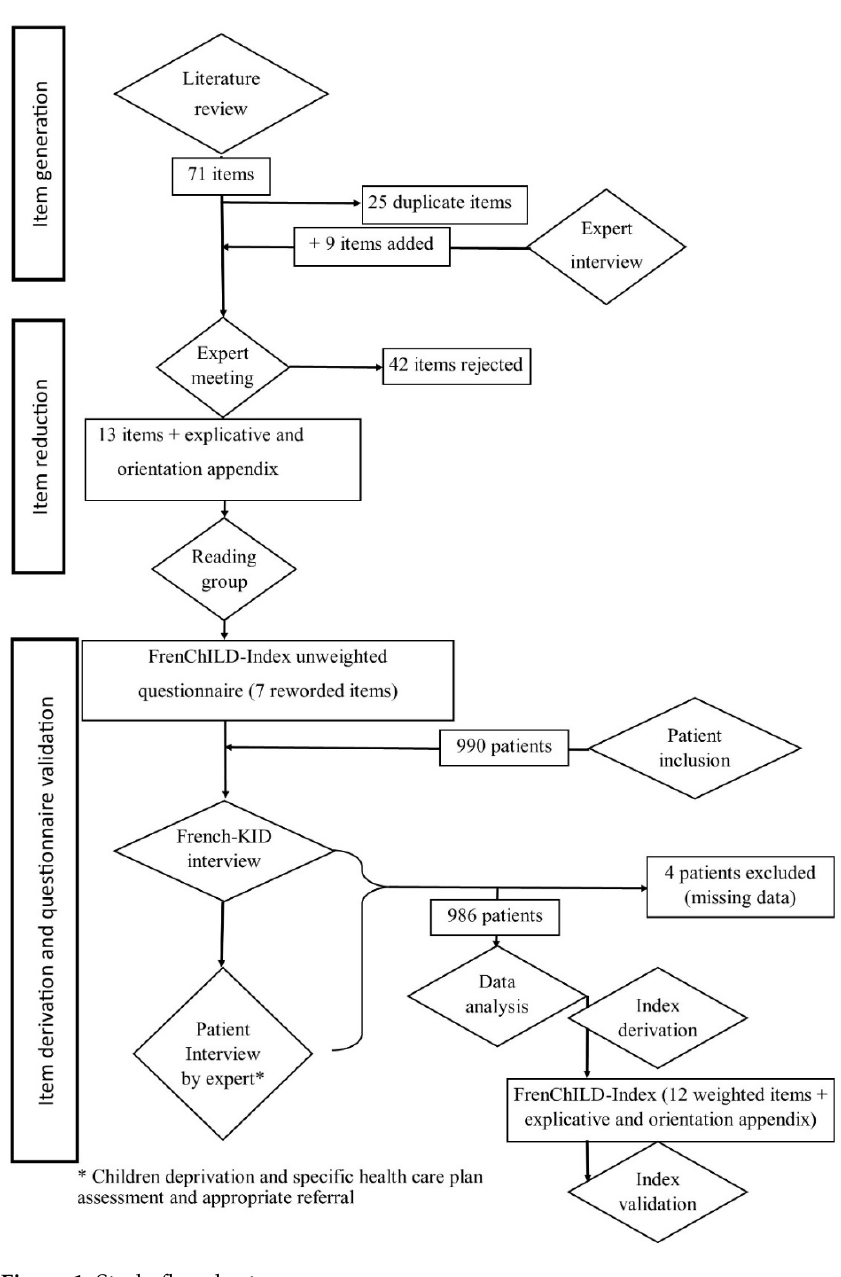
Figure 1. Study flowchart.